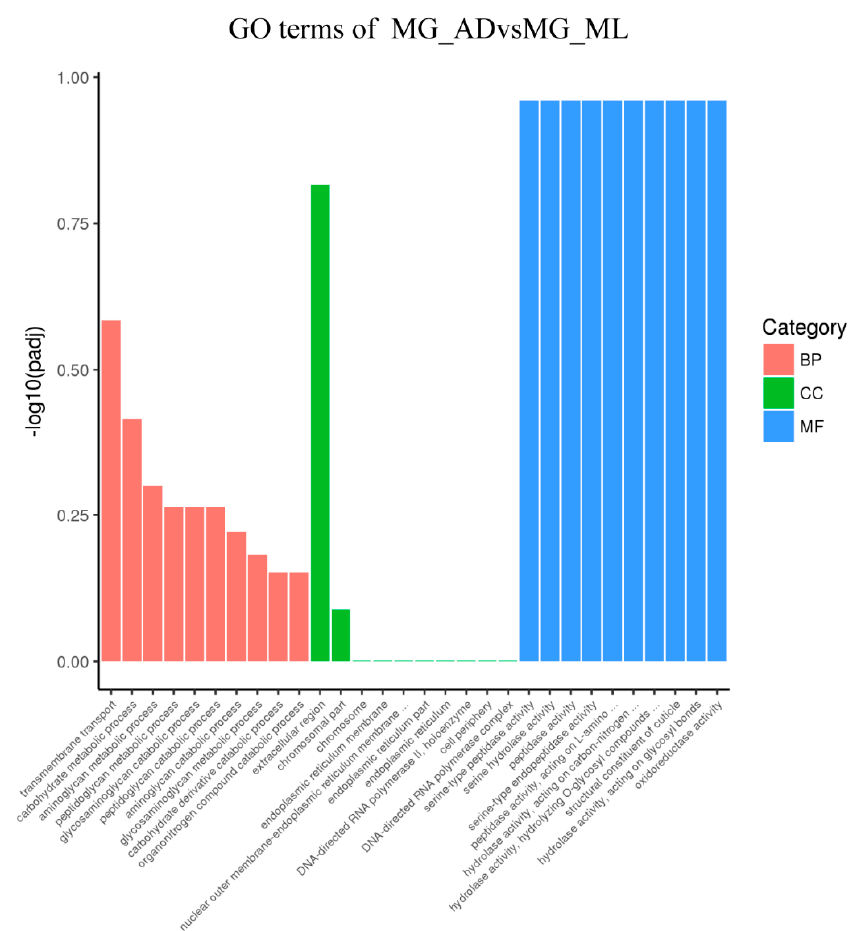
Figure 6. GO enrichment of MG_ADvsMG_ML. The differentially expressed genes were mainly related to biological processes (BP) such as transmembrane transport, carbohydrate metabolic pro- cess, aminoglycan metabolic process; cell components (CC) only related to extracellular region and chromosomal part, and the molecular functions (MF) such as serine-type peptidase activity, serine hydrolase activity and peptidase activity.